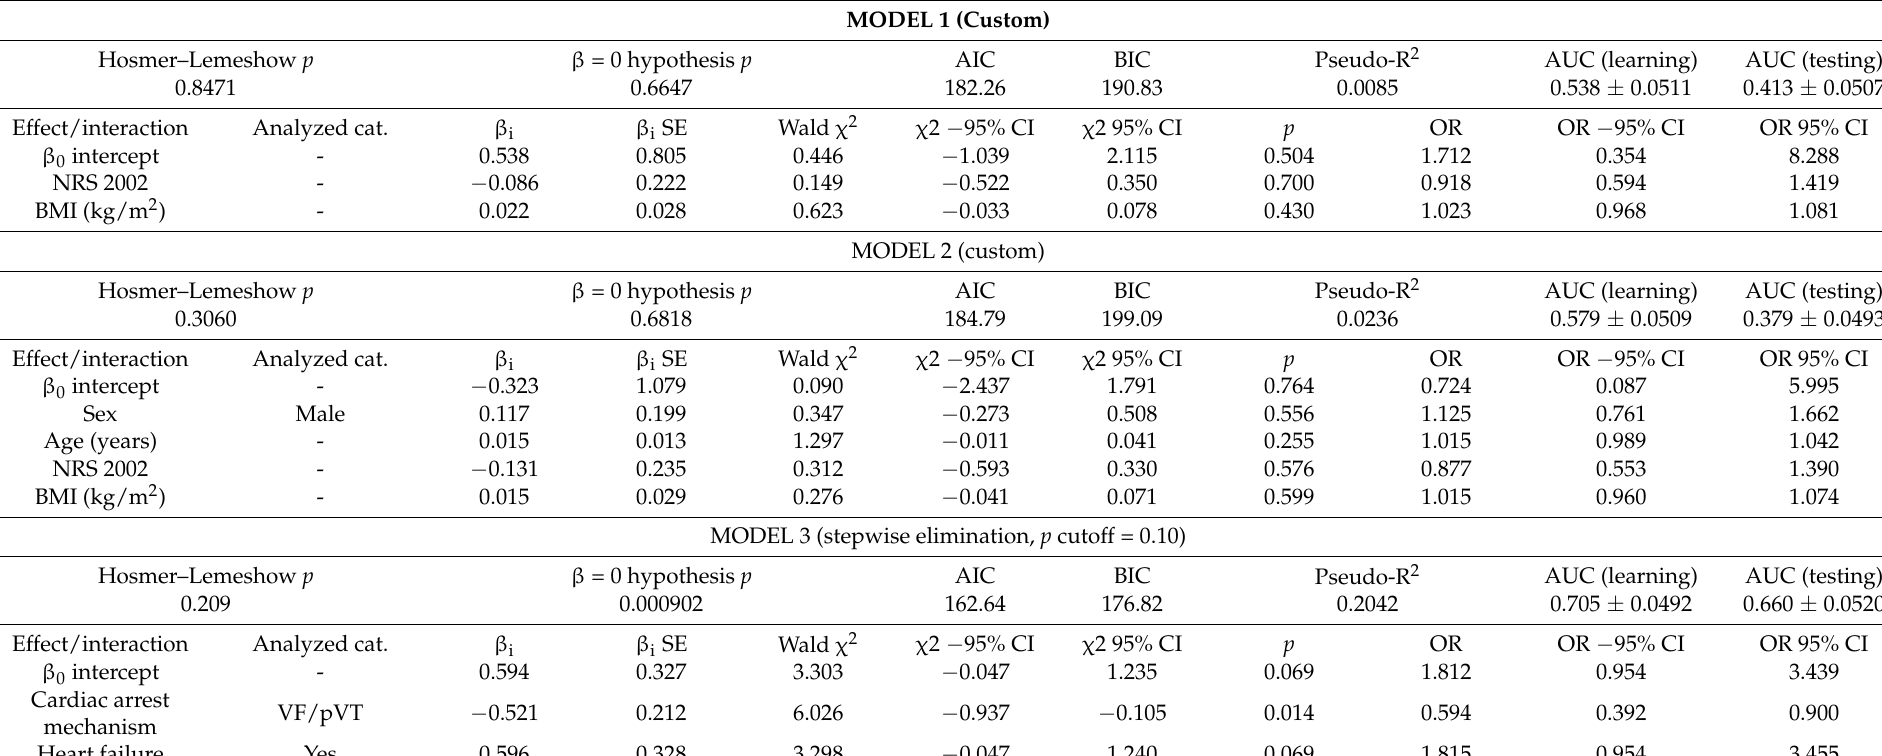
Table 6. Association between selected parameters and odds of death (multivariate logistic regression—all analyzed